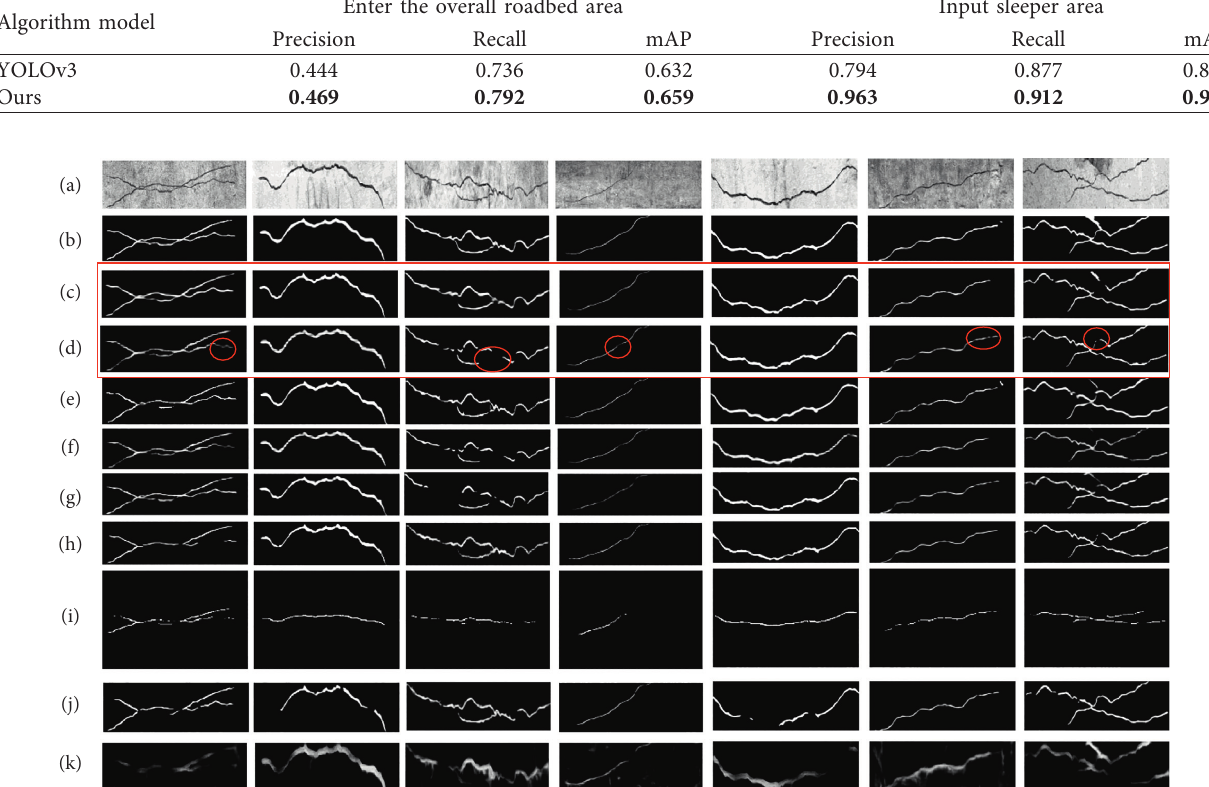
Figure 12: Comparison of saliency maps. (a) Image. (b) Ground truth. (c) Ours. (d) CEDNet. (e) EDR. (f) BAS. (g) POOLNet. (h) R2Net. (i) PFA. (j) SOD 100k. (k) HED.